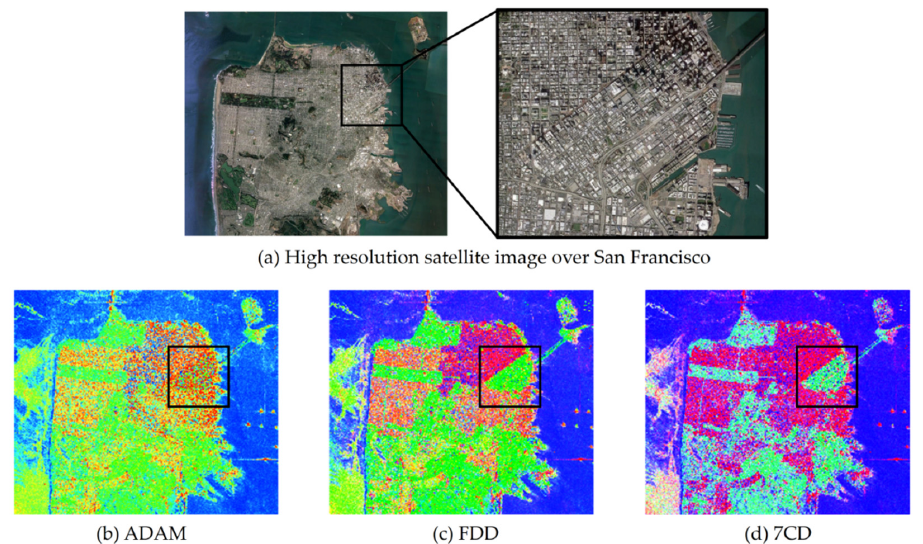
Figure 9. RGB-coded images of the decomposition results of ADAM, FDD, and 7CD with a reference high resolution satellite image over San Francisco ( P s —blue; P d —red; and P v —green).